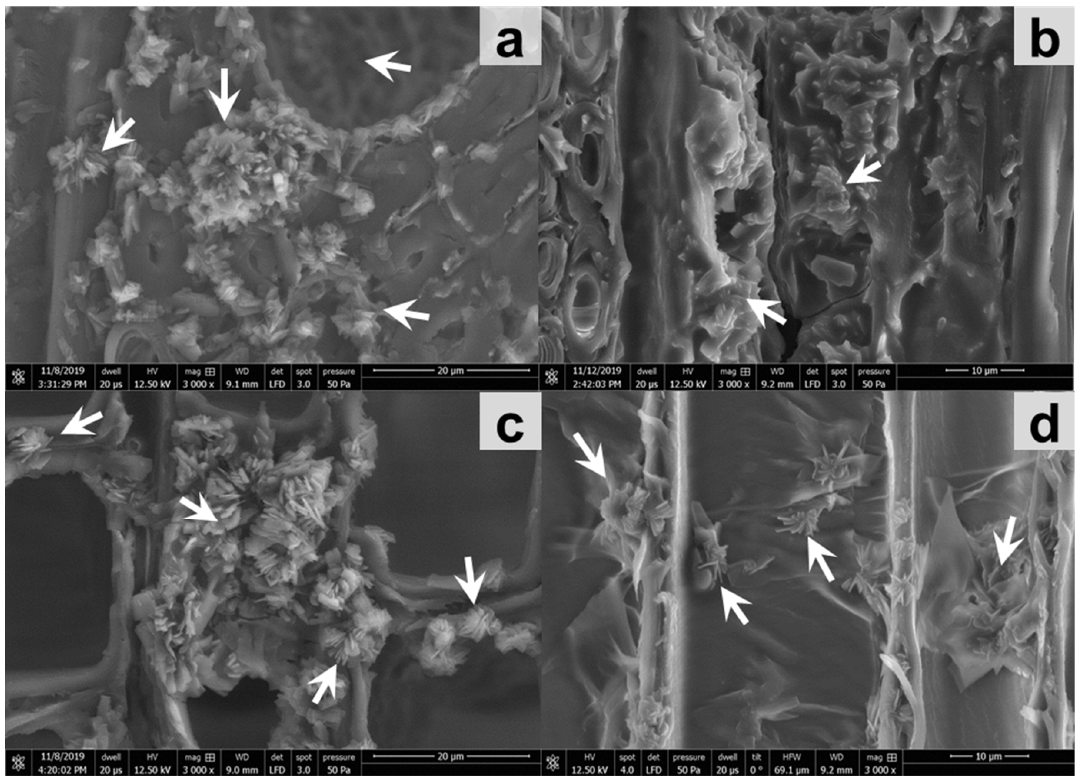
Figure 8. SEM micrographs of crystal-like structures in the lumina of cells in wood impregnated with the heartwood extract of black locust (HWE). ( a , b ) Beech sapwood ( Fagus sylvatica ) treated with the HWE. ( c , d ) Scots pine sapwood ( Pinus sylvestris ) treated with the HWE. ( a , c ) Transverse sections. ( b , d ) Longitudinal sections. The images were obtained at a magnification of 3000×.